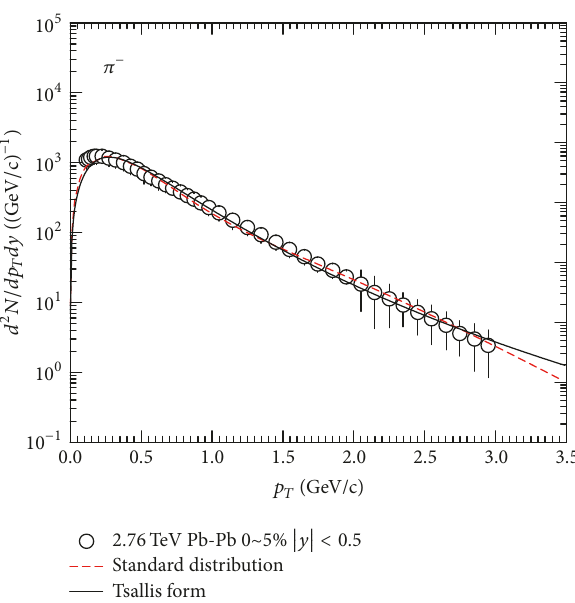
Figure 4: Same as Figure 1, but for central Pb-Pb collisions at √𝑠 = 2.76 TeV. The symbols represent the experimental data of 𝑁𝑁 the ALICE Collaborations and errors are the root quadratic sum of statistical and systematic errors